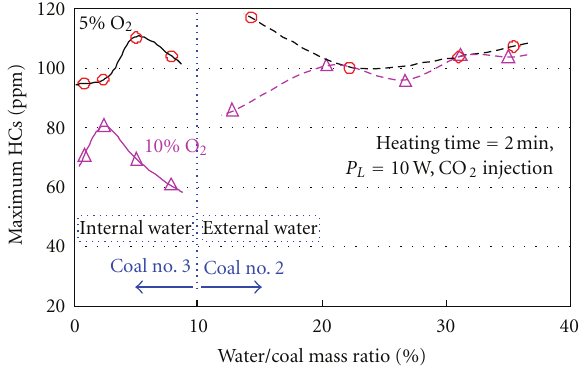
Figure 17: Maximum HCs gas concentration versus water/coal mass